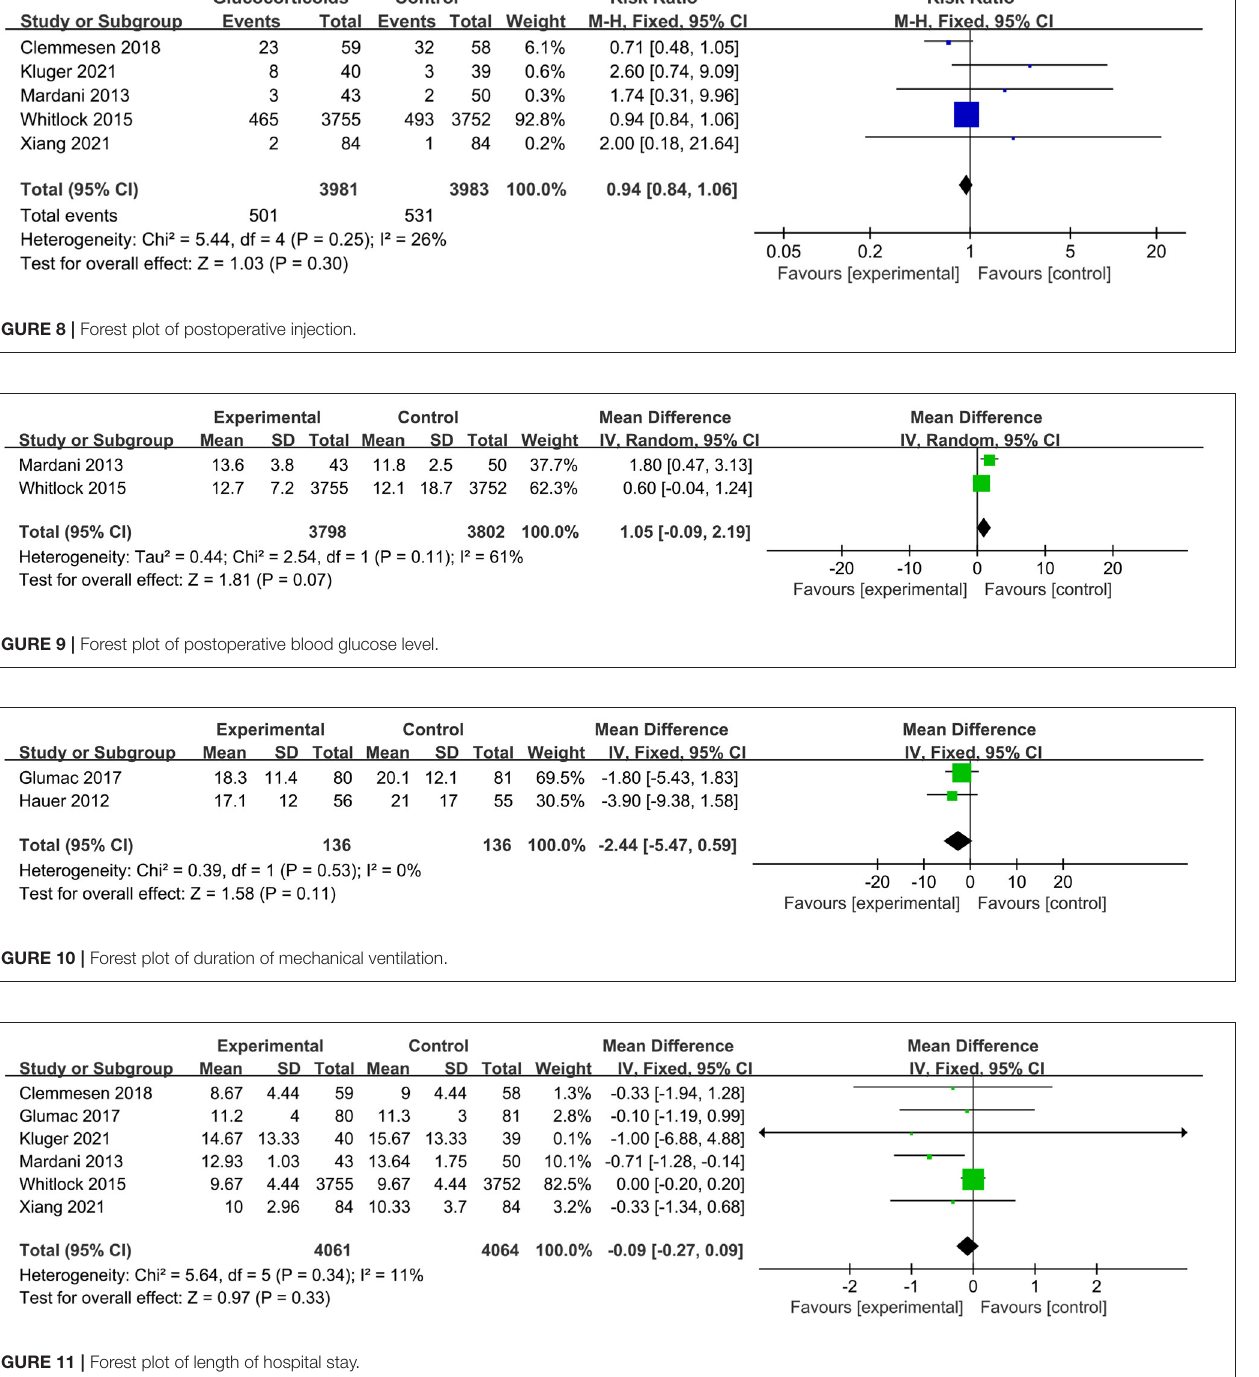
FIGURE 11 | Forest plot of length of hospital